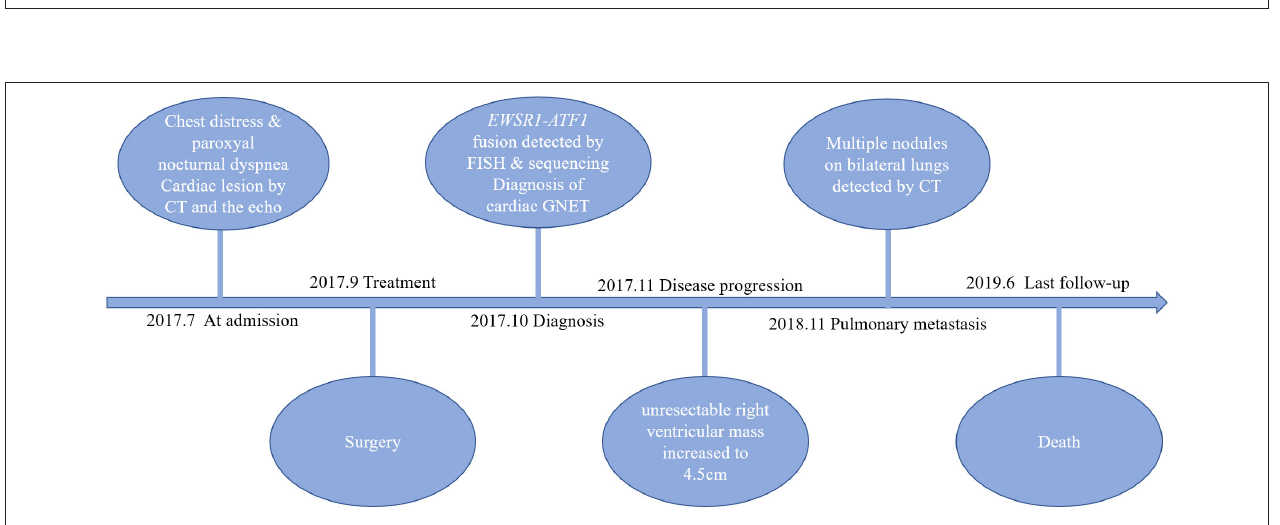
FIGURE 3 | Molecular characteristics of the lesion. (A) The rearrangement of EWSR1 (arrows) was found in about 50% of tumor cells by fluorescence in situ hybridization using EWSR1 break-apart probe. (B) EWSR1-AFTF1 dichromatic fusion probe also proved the tumor carrying the EWSR1 rearrangement (arrows). (C) Whole-transcriptome sequencing analysis confirmed that the fusion involved exon 8 of EWSR1 and exon 4 of ATF1 .